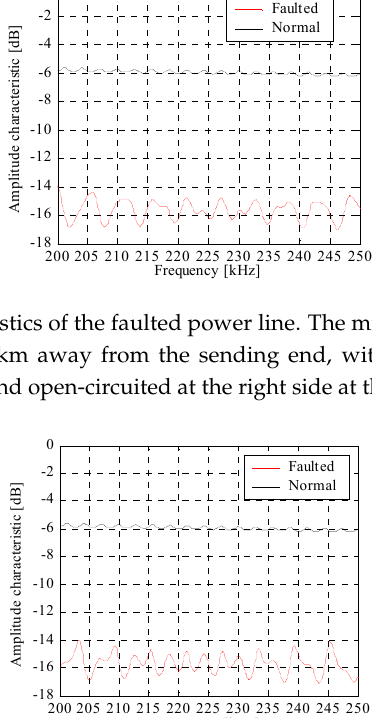
Figure 8. Amplitude characteristics of the faulted power line. The middle phase to ground coupling. The broken middle phase 25 km away from the sending end, with the middle phase conductor open-circuited at the both sides at the fault location.